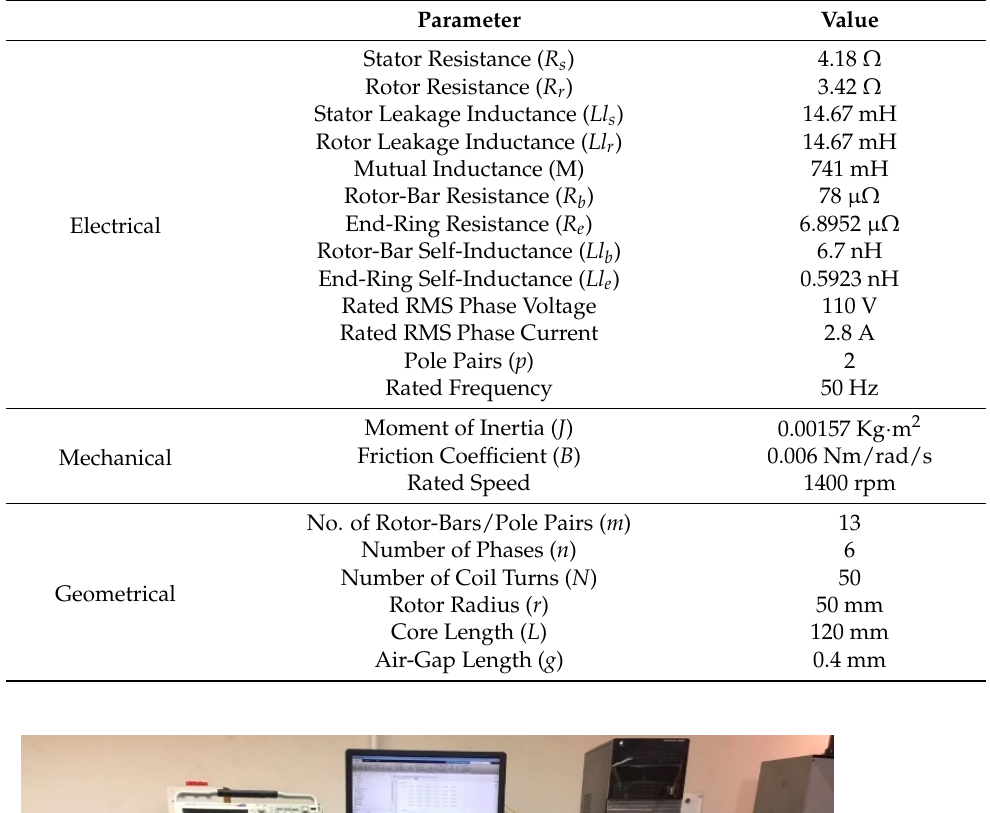
Table 1. Symmetrical six-phase induction motor parameters.